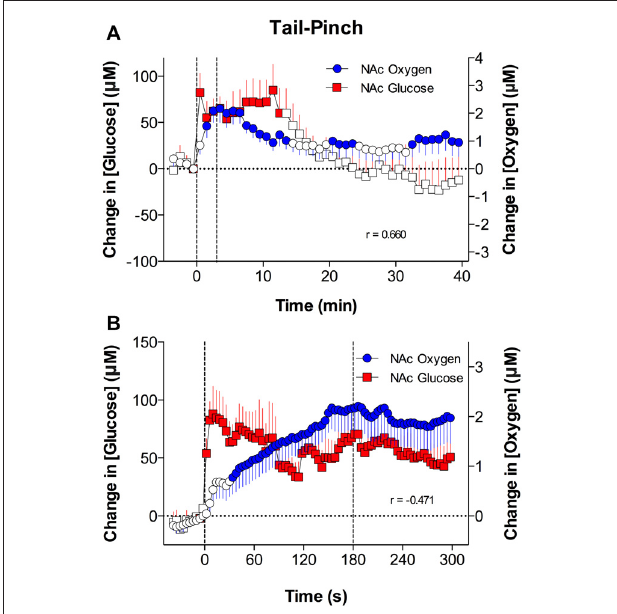
FIGURE 3 | Relationships between changes in NAc oxygen and glucose induced by tail-pinch. Top graphs (A) , show mean ( ± SEM) changes in concentrations of oxygen and glucose analyzed with slow time resolution (1-min bins) and bottom graph (B) shows changes analyzed with rapid time resolution (4-s bins). Vertical dotted lines show onset and offset of tail-pinch. Each graph shows coefficients of correlation (r). Original data were published in Solis et al.